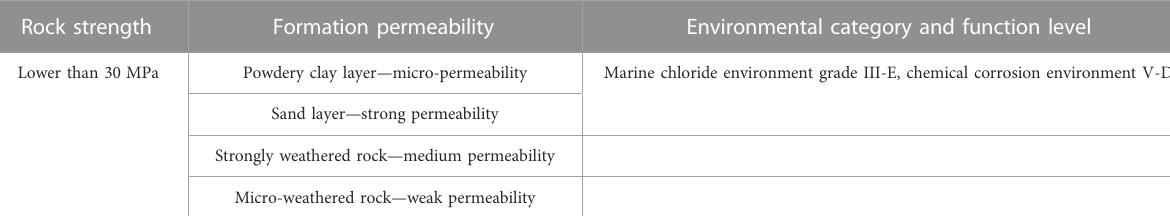
FIGURE 1 Interval general